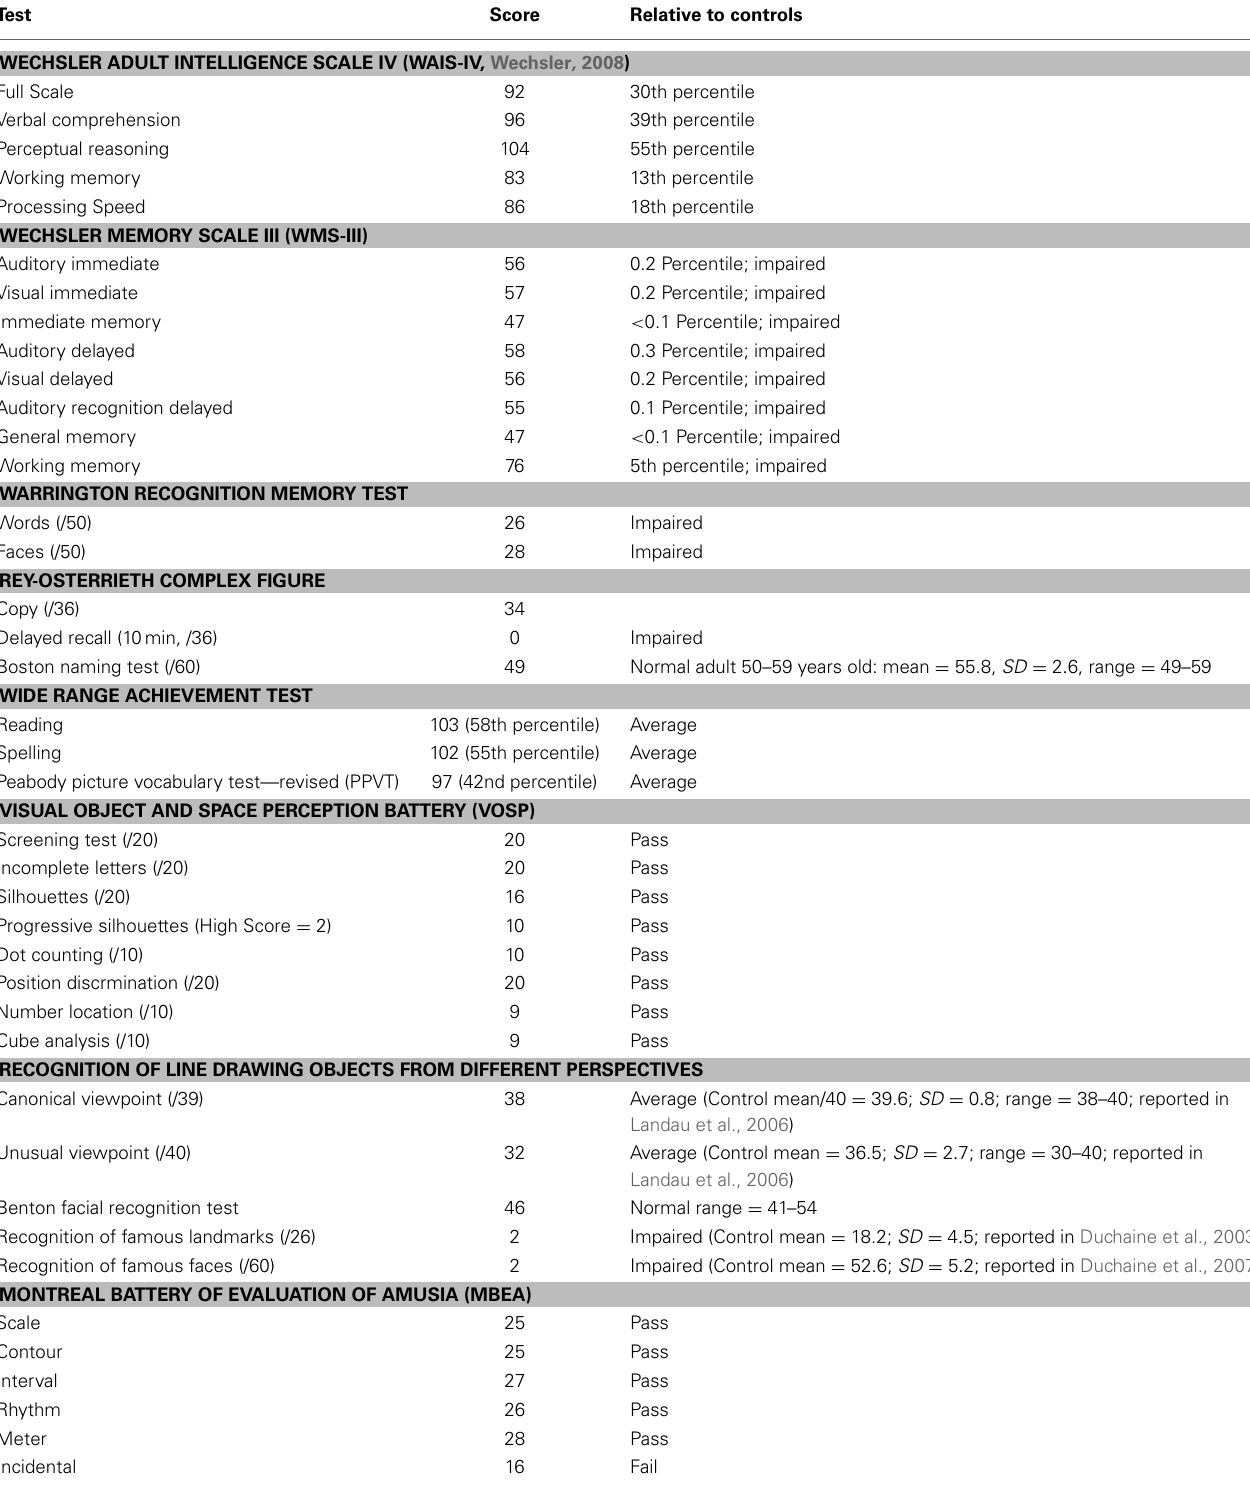
Table 1 | Neuropsychological profile of patient